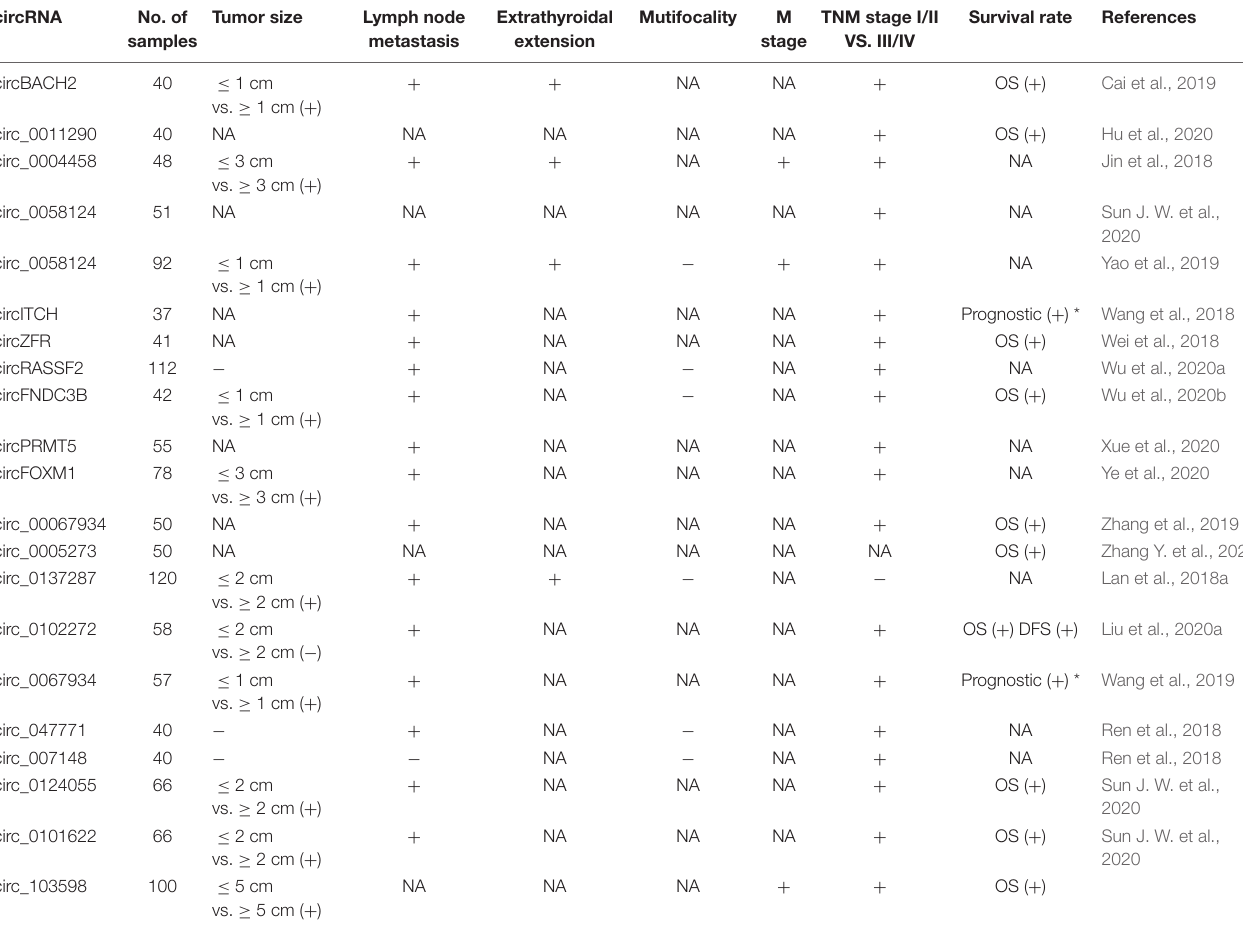
TABLE 3 | CiRNAs and TC diagnosis and prognosis. circRNA No. of Tumor samples